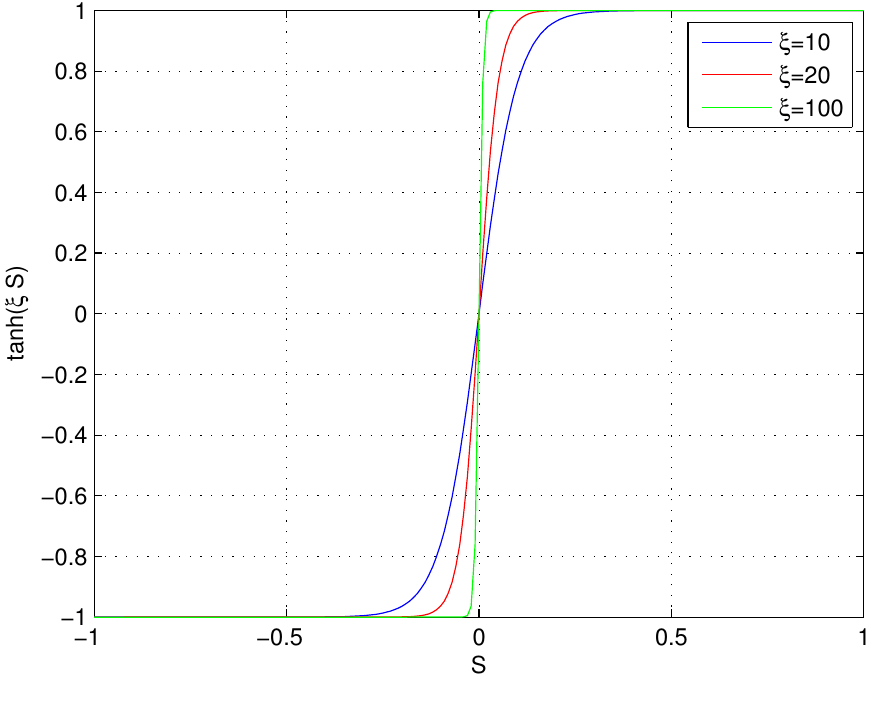
Figure 2. tanh( ξ S ) function for di ff erent ξ